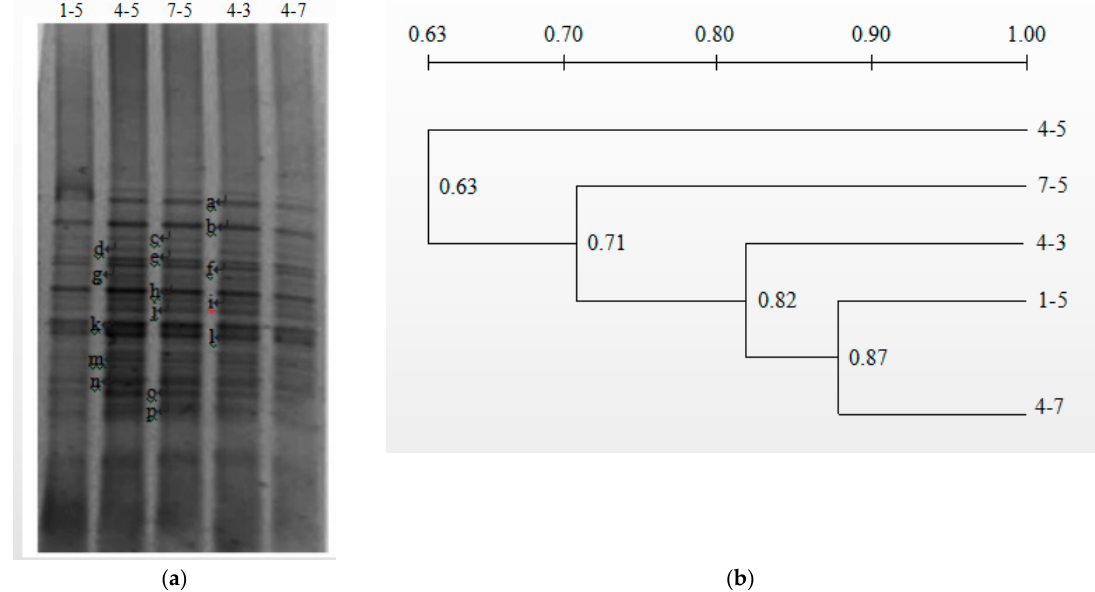
Figure 8. Study of the Microbial flora characteristics: ( a ) DGGE profile of total bacteria in activated sludge samples and ( b ) UPGMA cluster analysis of DGGE.